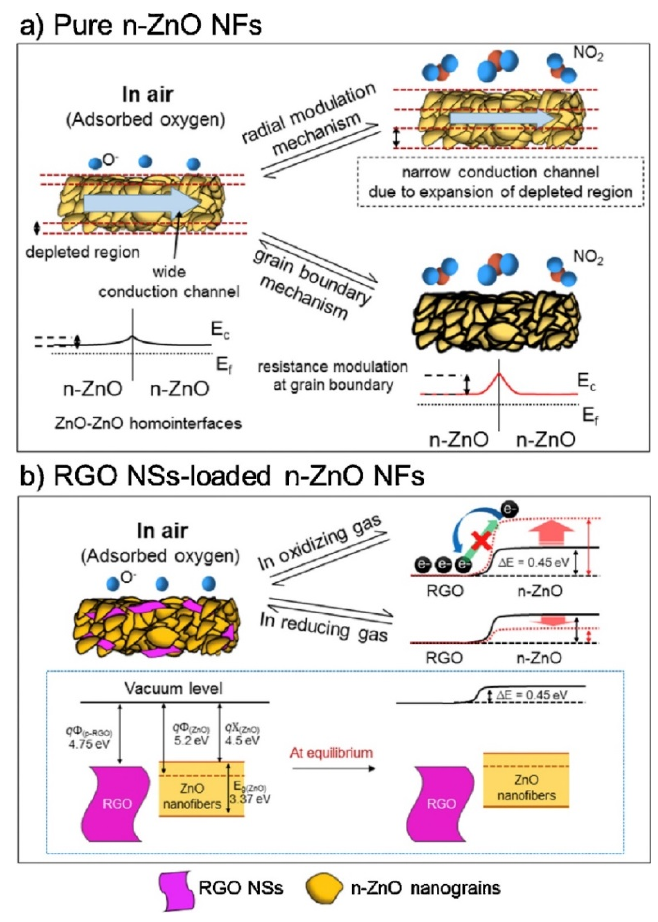
Figure 6. NO 2 gas sensing mechanism of ( a ) ZnO NFs and ( b ) rGO-loaded ZnO NFs [59].